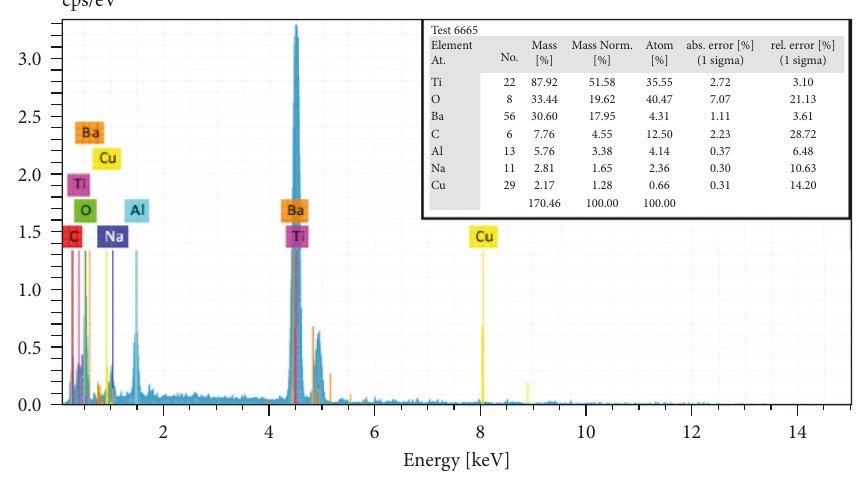
Figure 8: EDS analysis for L 4 workpiece using brass wire as a tool.